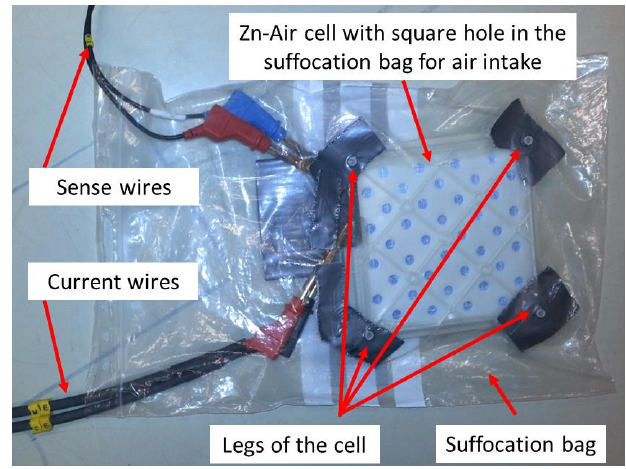
Figure 2. Open air setup, the back side of the cell with the air holes, shown in the figure, had free access to air.